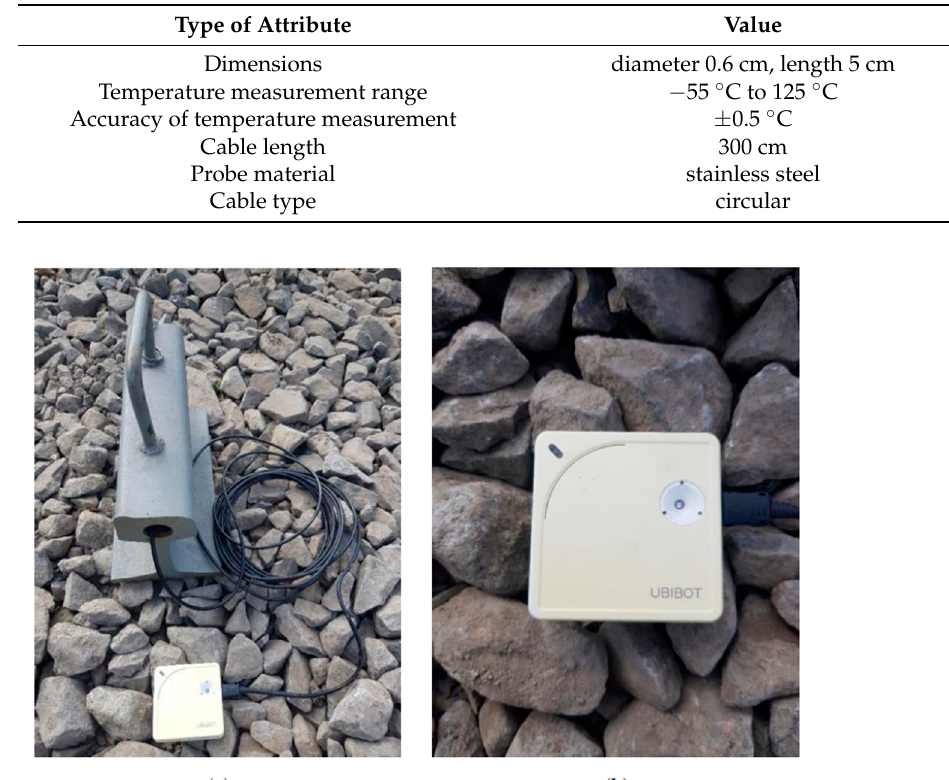
Table 3. Technical characteristics external temperature sensor DS18B20.